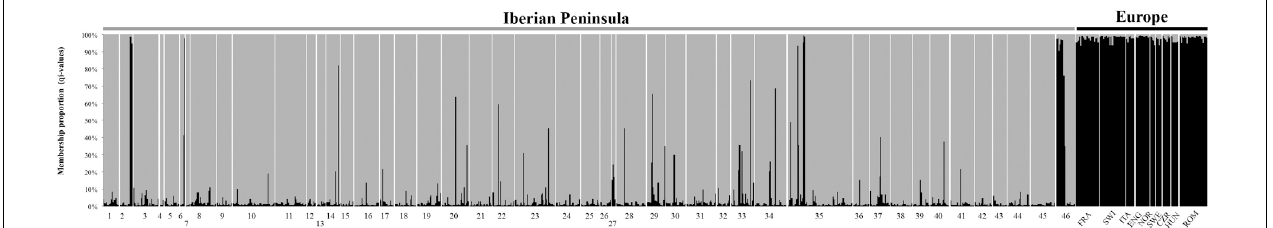
FIGURE 3 | Bayesian clustering analyses conducted in STRUCTURE for K = 2. Individual membership proportion to each cluster is indicated in gray for the Iberian populations (codes as in Figure 1 ) and black for the European populations (FRA, France; SWI, Switzerland; ITA, Italy; ENG, England; NOR, Norway; SWE,